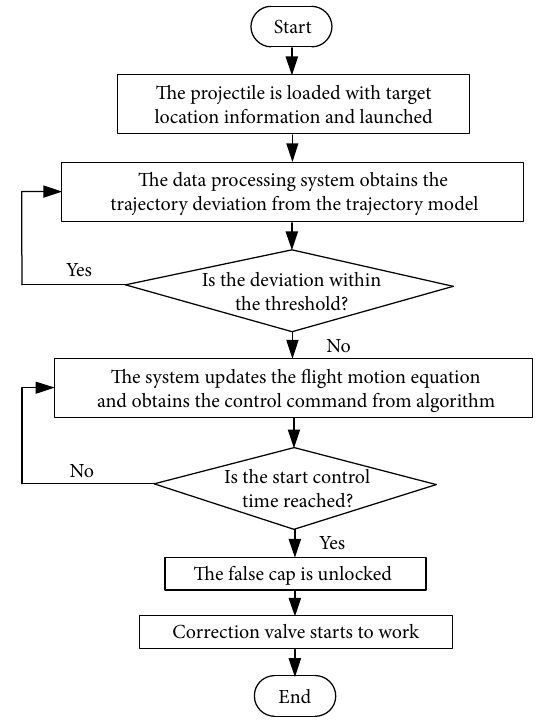
Figure 4: The working process of the projectile ’ s control